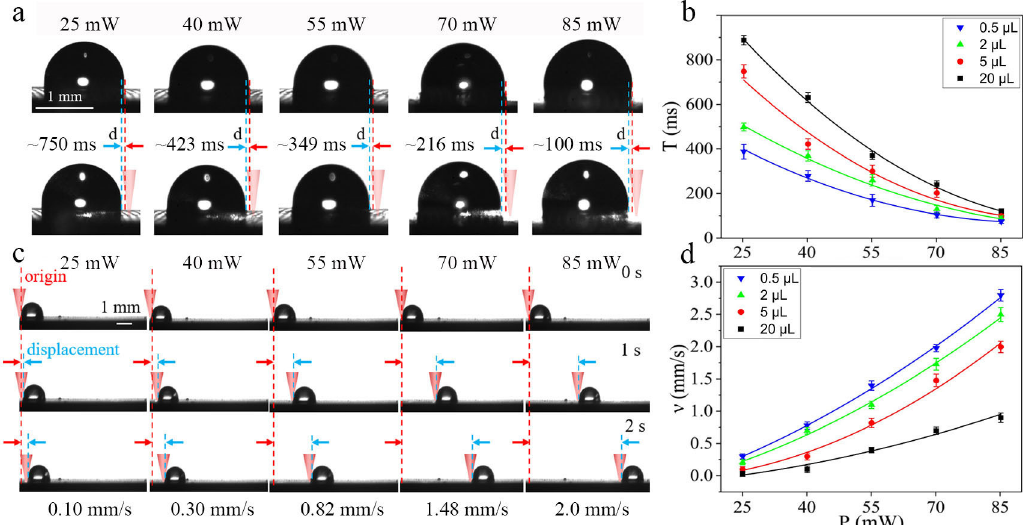
Figure 3. Performance of HD-PTSS irradiated with different NIR light power. ( a ) Instantaneous response time at different NIR light power. ( b ) Relationship between instantaneous response time and NIR light power of droplets with different volume. ( c ) Driving speed at different NIR light power. ( d ) Relationship between driving speed and NIR light power of droplets with different volume.